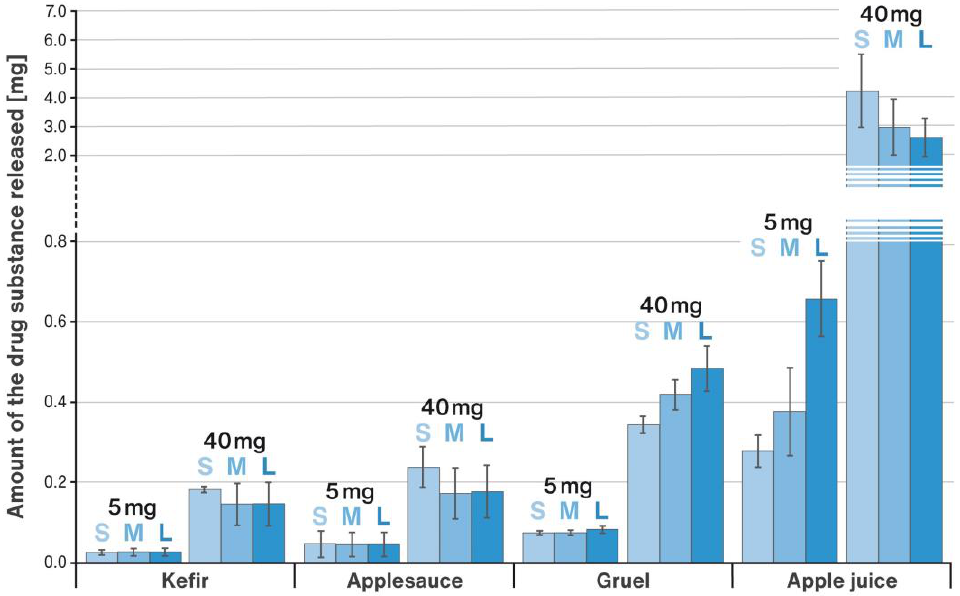
Figure 6. Comparison of the amount of RSC released from S, M, and L size sprinkle multiparticulates during contact with a soft food or liquid; mean values with n = 3, SD is indicated by error bars.